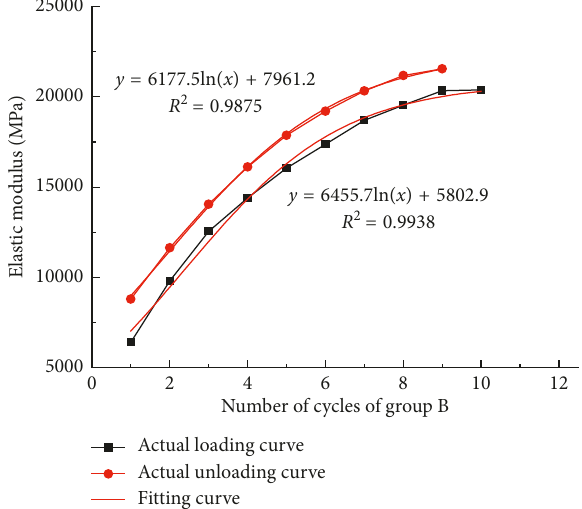
Figure 8: Curve of elasticity modulus and